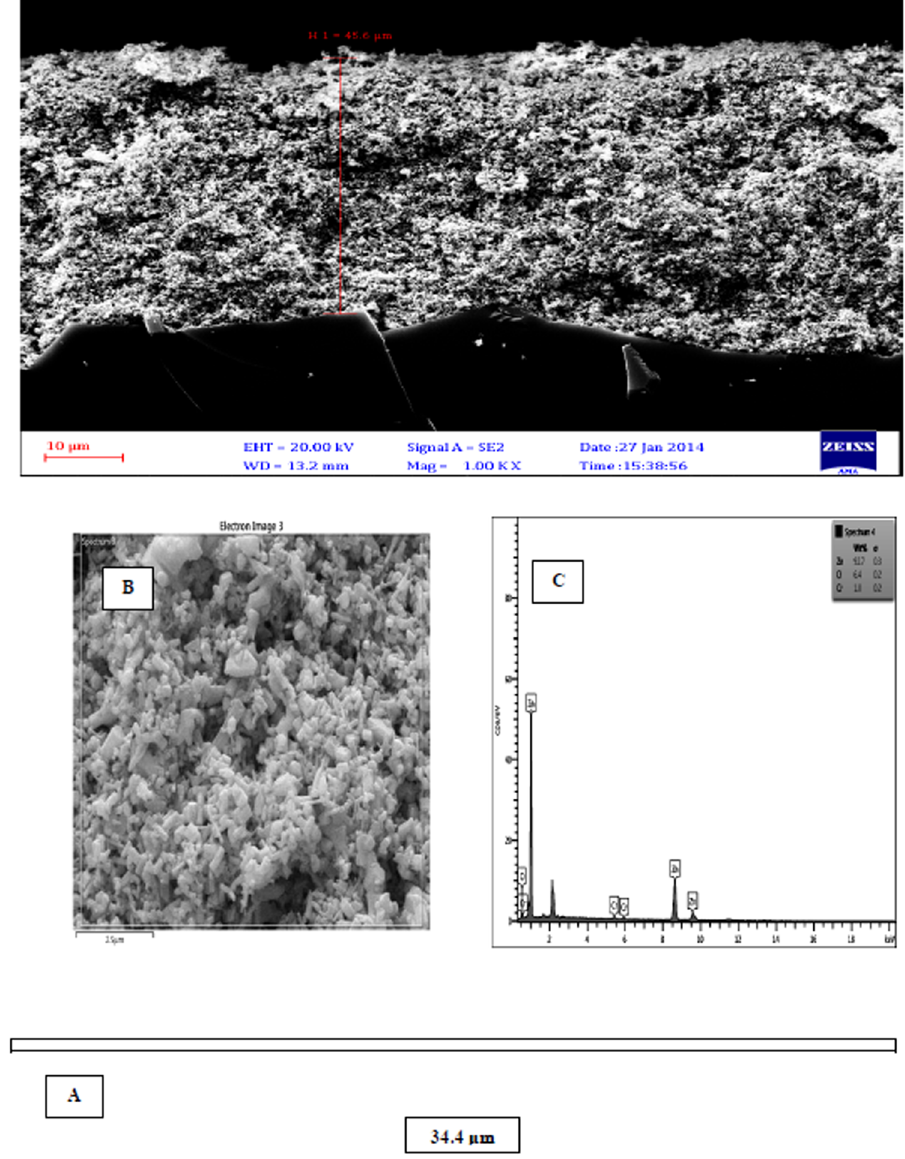
Figure 6. ( A ) Cross sectional SEM image; ( B ) Surface based SEM image; ( C ) EDX diagram based on three layers of doped zinc oxide nanoparticles immobilized on the glass